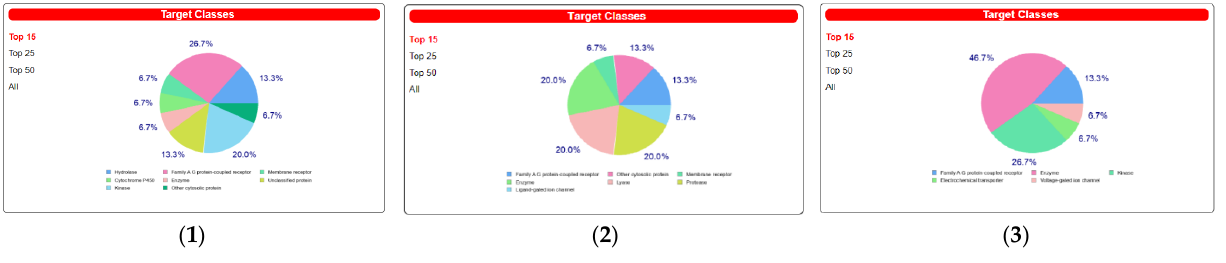
Figure 7. The target classes of palmatine ( 1 ), metformin ( 2 ), and glimepiride ( 3